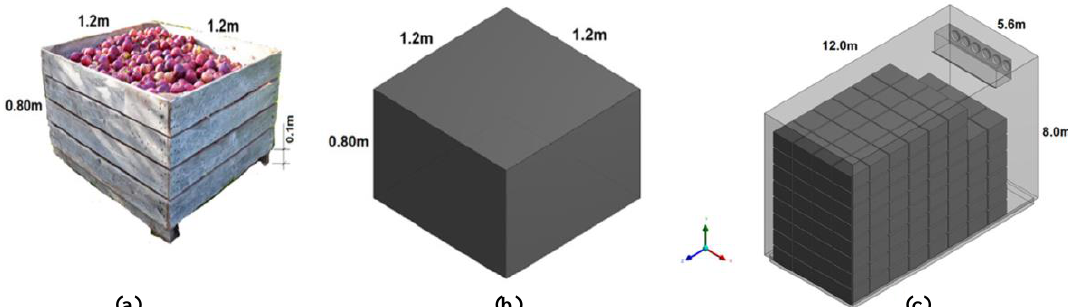
Figure 2. ( a ) Wooden bin loaded with randomly packed fruit ( b ) porous medium model of a bin ( c ) porous replica of bins placed in a cold room [46].